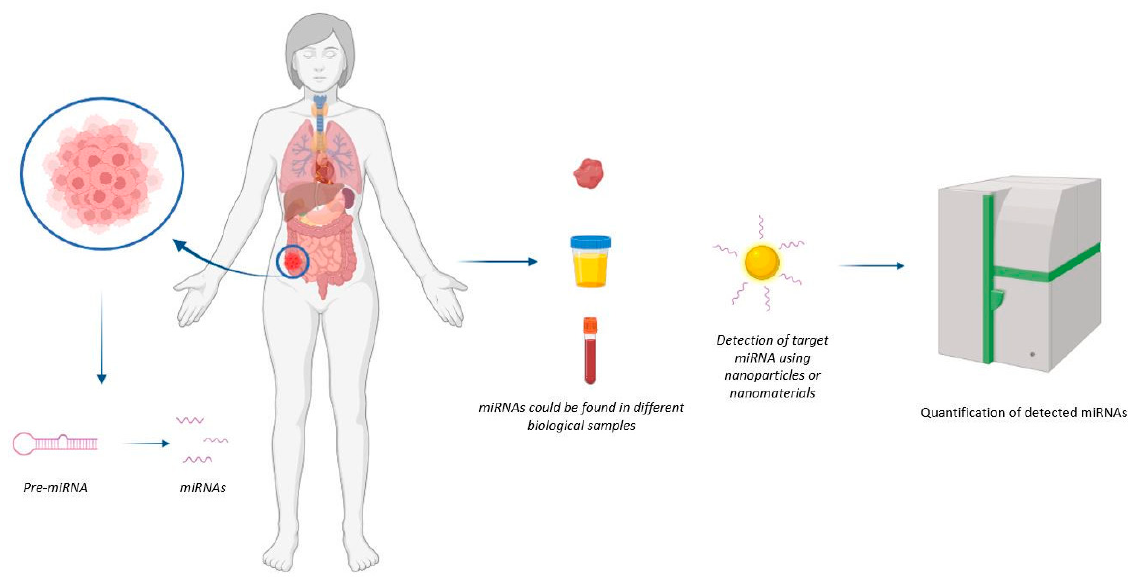
Figure 1. Representation of mechanism of action of nanodevices for miRNA detection. The nanodevice can detect the miRNA of interest at the tumour site.